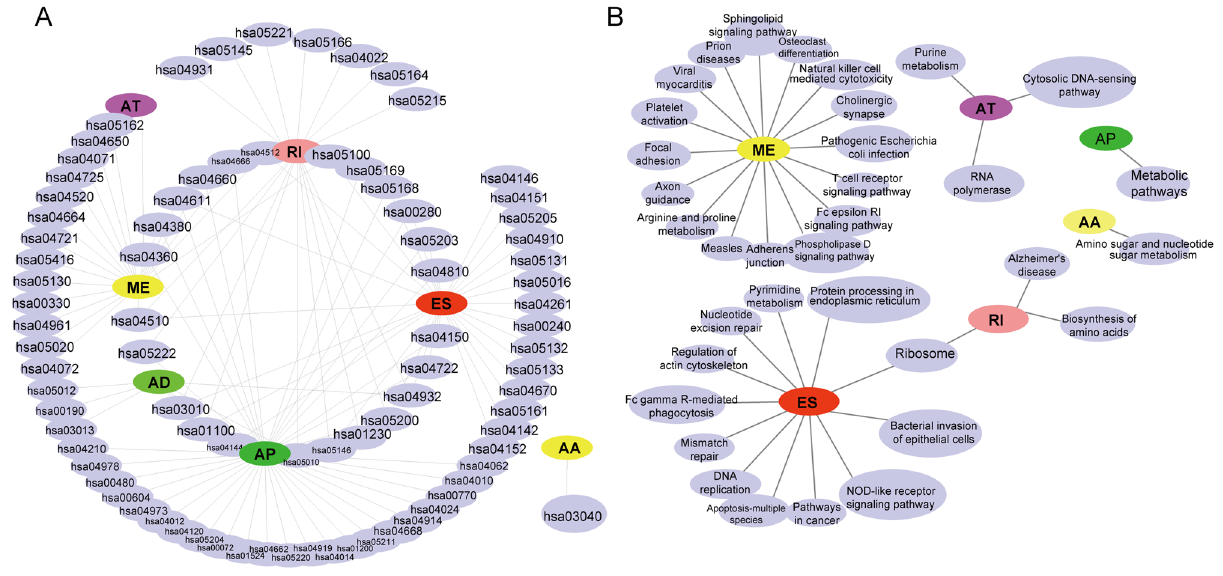
Figure 4. Functional annotations of AS events. ( A ) A KEGG enrichment analysis of the genes that were significantly related to overall survival. The AS events, such as ES, AP, RI, and ME, were the top 4 AS events that showed significant correlation with genes related to overall survival prognoses. ( B ) The KEGG enrichment results for the AS genes with the highest values for gene significance. AS events are closed linked to various biological functions. The results indicated that the ES and ME events are involved in complex pathway interactions, such as those related to nuclear, cancer, and immune cell pathways, among others.